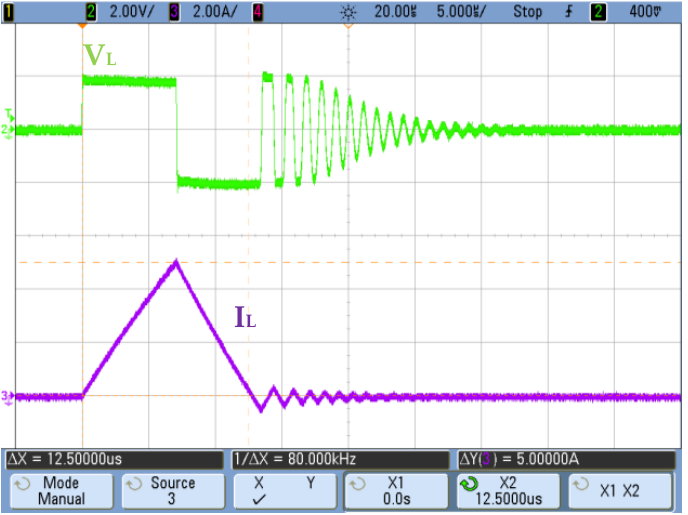
Figure 15. Triangular current (Channel 3, purple) and voltage pulse (Channel 2, green) applied to the transducer. Only full-bridge used.